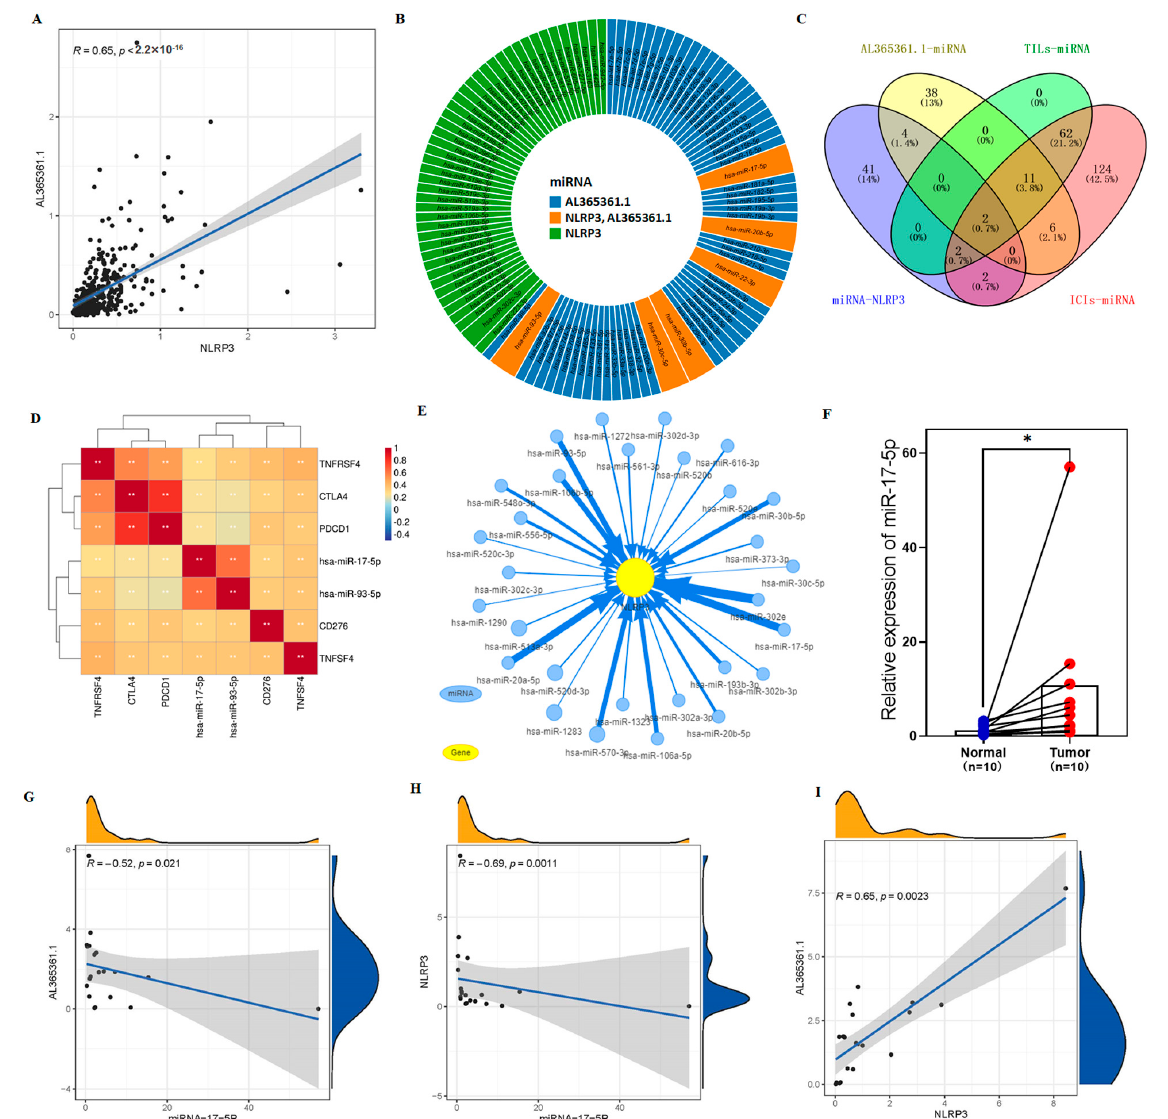
Figure 11. The regulatory network between AL365361.1 and NLRP3. ( A ) The scatter plot of correlation showing the correlation of the expression levels between AL365361.1 and NLRP3. ( B ) The sunburst diagram shows predicted microRNA targets of NLRP3 and AL365361.1. ( C ) The Venn diagram containing four lists of miRNAs. ( D ) The correlation heatmap between the 2 common miRNAs and the main immune checkpoint genes. ( E ) The network of the potential regulation of miRNAs to NLRP3. ( F ) The differential analysis plots show the expression of miR-17-5p in HCC tissue and adjacent normal tissue from HCC patients. The scatter plot of correlation shows the correlation of the expression levels between AL365361.1 and hsa-miR-17-5p ( G ), NLRP3 and hsa-miR-17-5p ( H ), AL365361.1 and NLRP3 ( I ). * p < 0.05, ** p < 0.01. p < 0.05 was considered statistically significant.